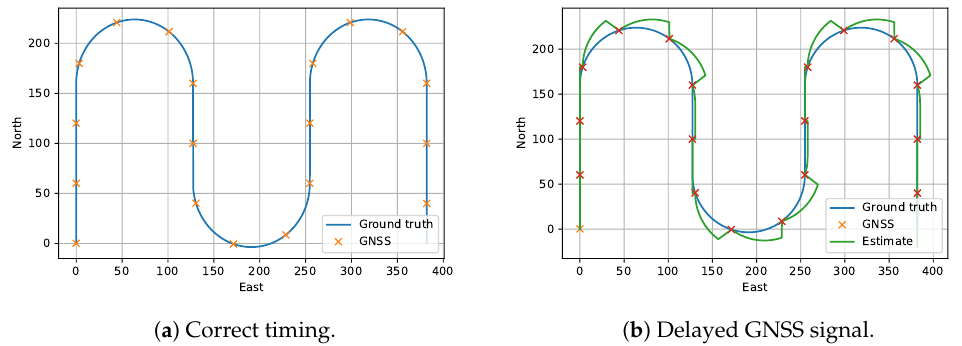
Figure 2. Comparison of a system with perfect timing ( a ) and a system with imperfect timing ( b ). The UAV has a velocity of 20ms − 1 an uncompensated GNSS time delay of 1s. Note that this time delay is exaggerated to show the effect clearly, and is larger than an expected delay in an implemented navigation